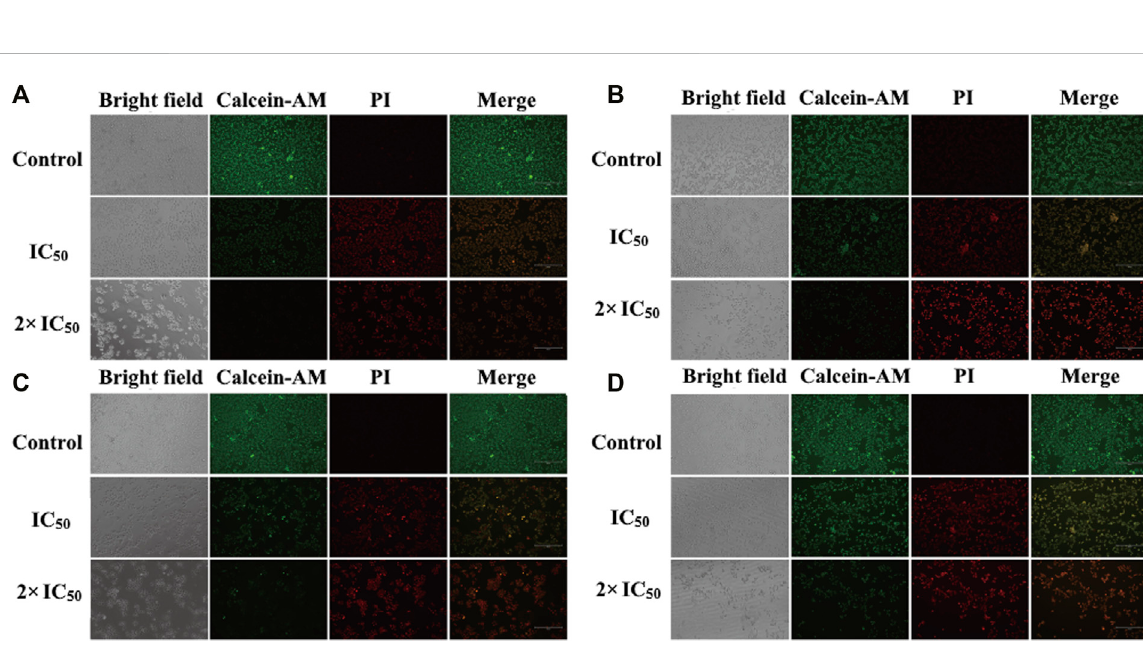
the apoptosis rates (Q2 + Q3) of the control groups were rather low (Table 4). For the control group, both HepG2 and Huh7 cell viability are very high (87.27% for HepG2 and 93.99% for Huh7), while concentration-dependent cell viability was observed for those treated